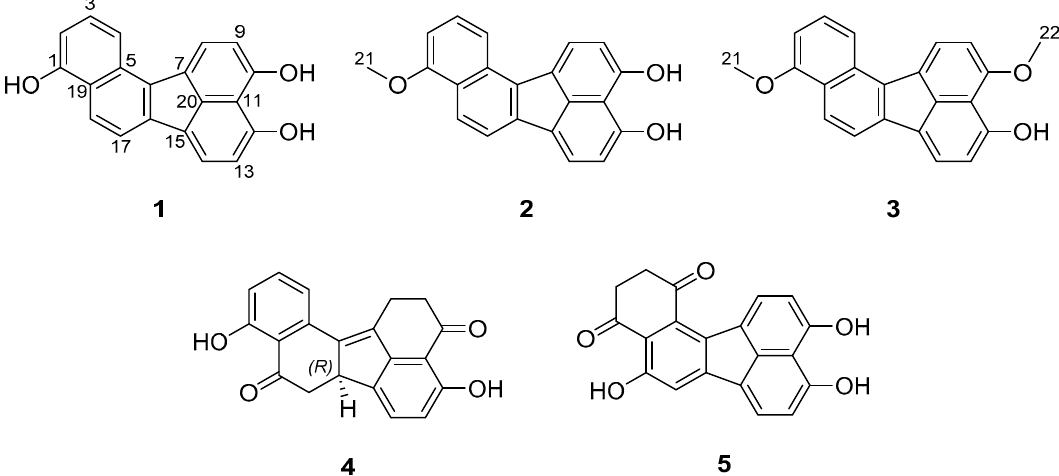
Figure 1. Structures of secondary metabolites isolated from stromata of Annulohypoxylon viridistratum . 1 − 3 : viridistratins A − C, 4 : truncatone A and 5 : truncatone C.